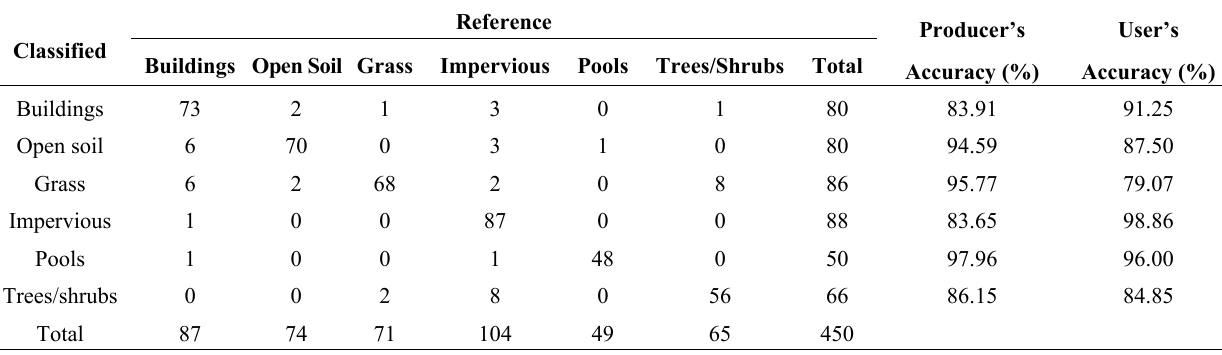
Table 1. Classification accuracy of the object-oriented